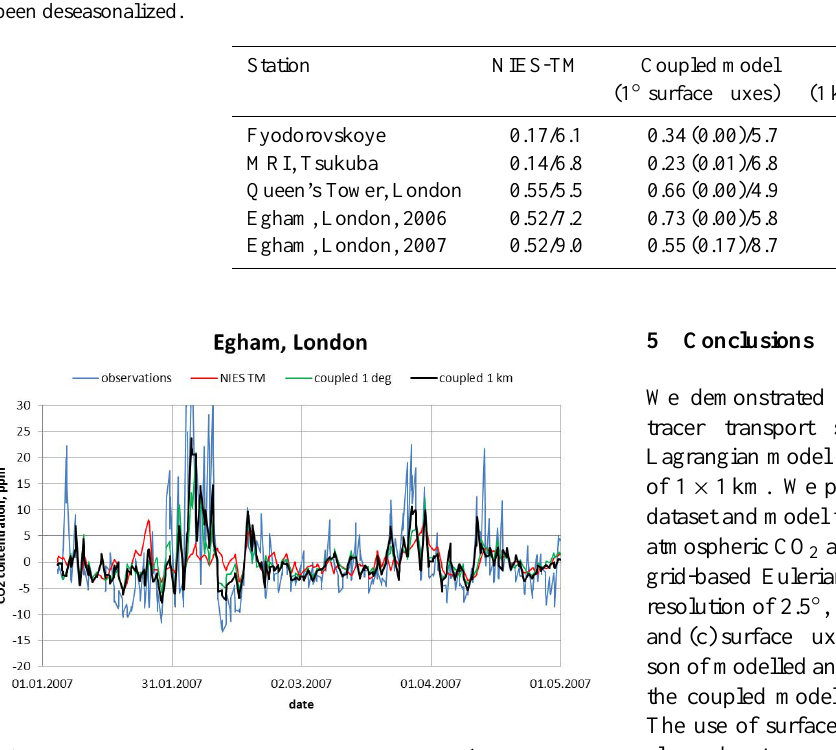
Fig. 6. Deseasonalized results for Egham, London (representative 4-month time